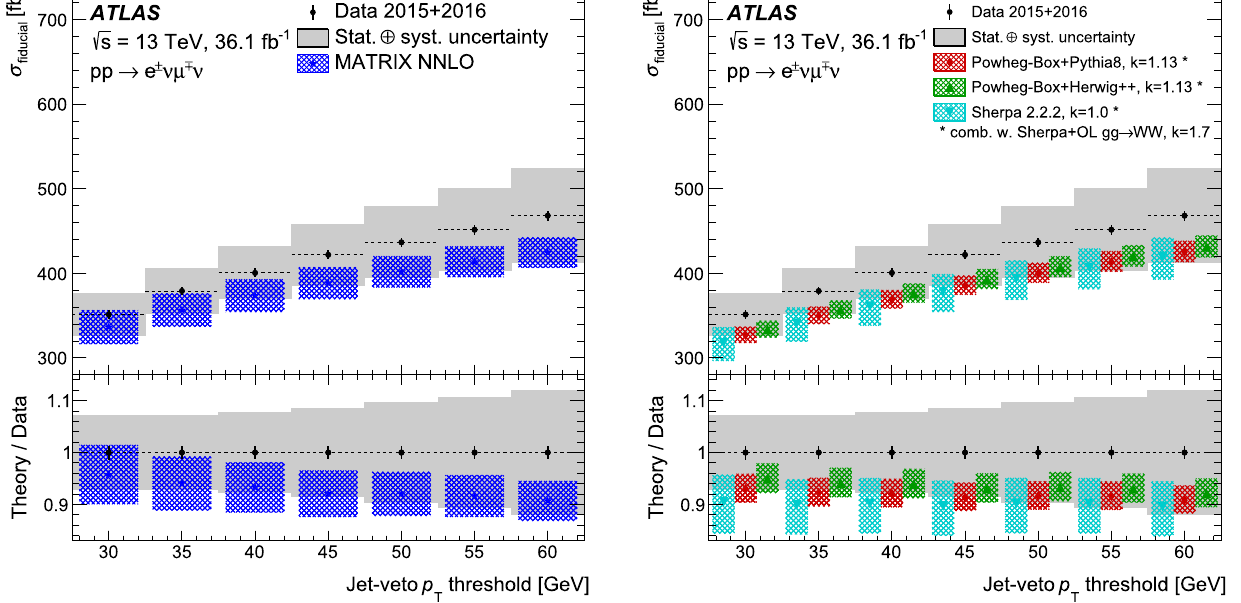
bined with Sherpa + OpenLoops (LO+PS) for the gg initial states is shown. All three q ¯ q NLO+PS predictions are normalized to the NNLO theoretical prediction for the total cross-section, with the gg LO+PS contribution normalized to NLO. The measured cross-section values are shown as points with error bars giving the statistical uncertainty and solid bands indicating the size of the total uncertainty. Theoreti- cal predictions are indicated as markers with hatched bands denoting PDF+scale